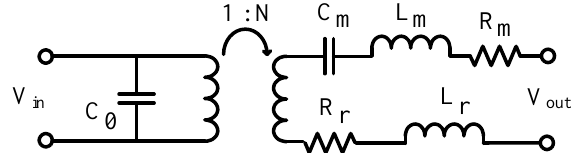
Figure 4. Equivalent circuit of a